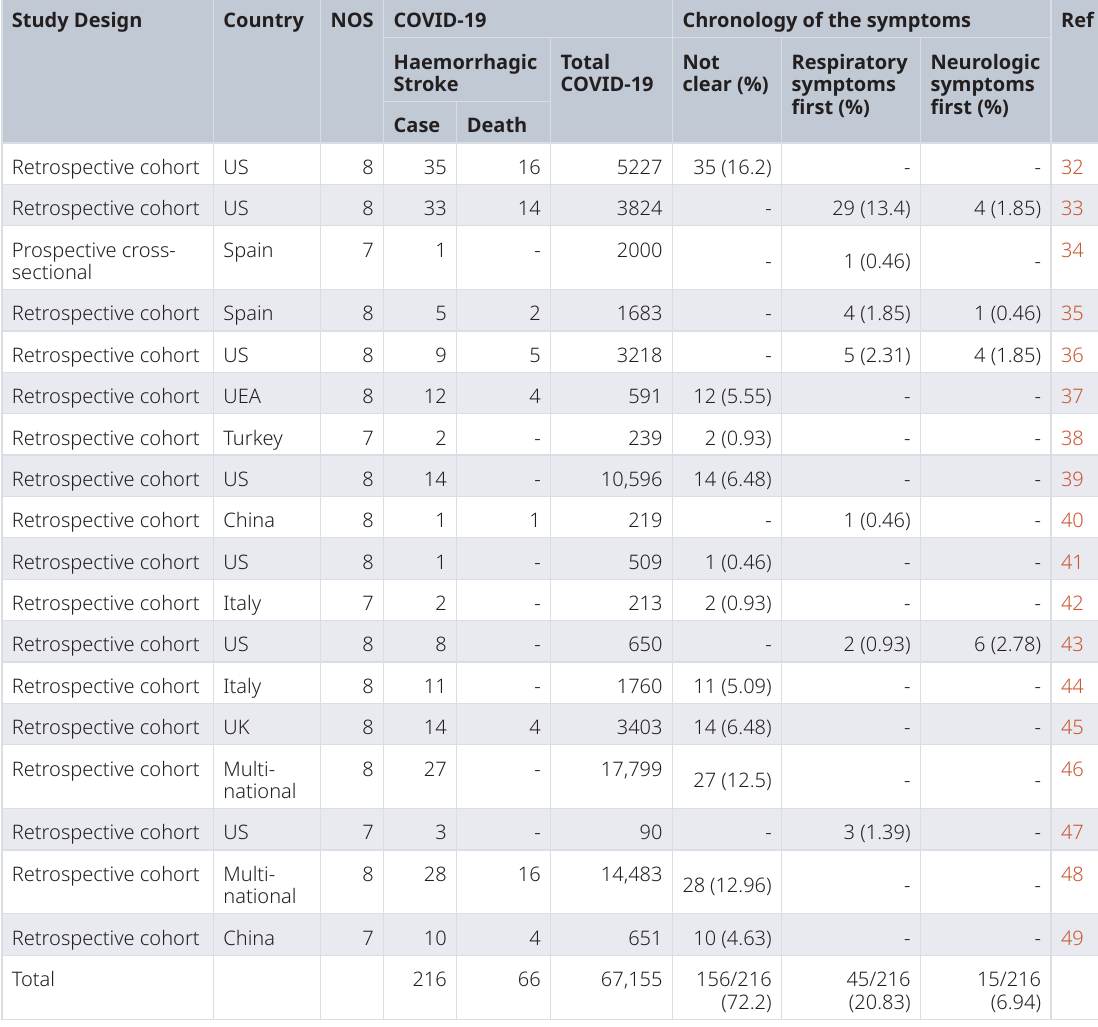
Table 1. The prevalence of haemorrhagic stroke among COVID-19 patients around the globe. Study